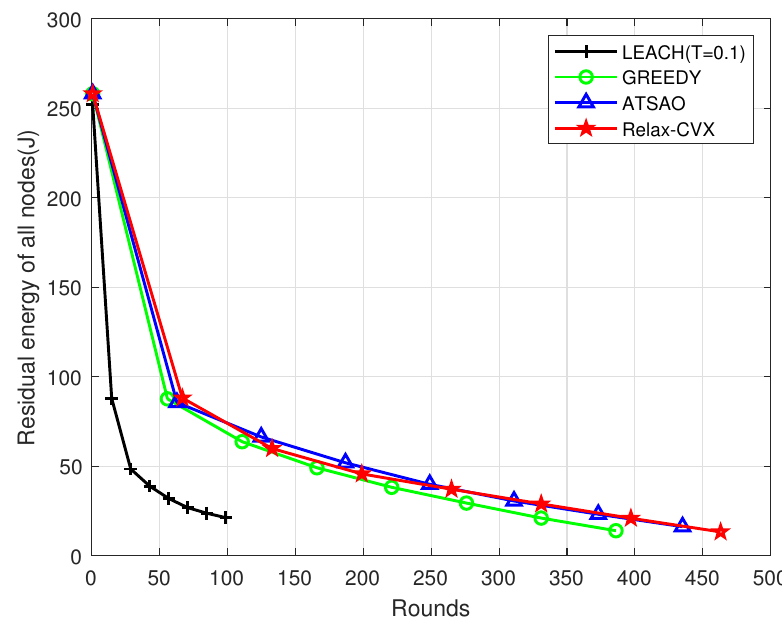
Figure 5. Residual energy of all nodes versus number of rounds.